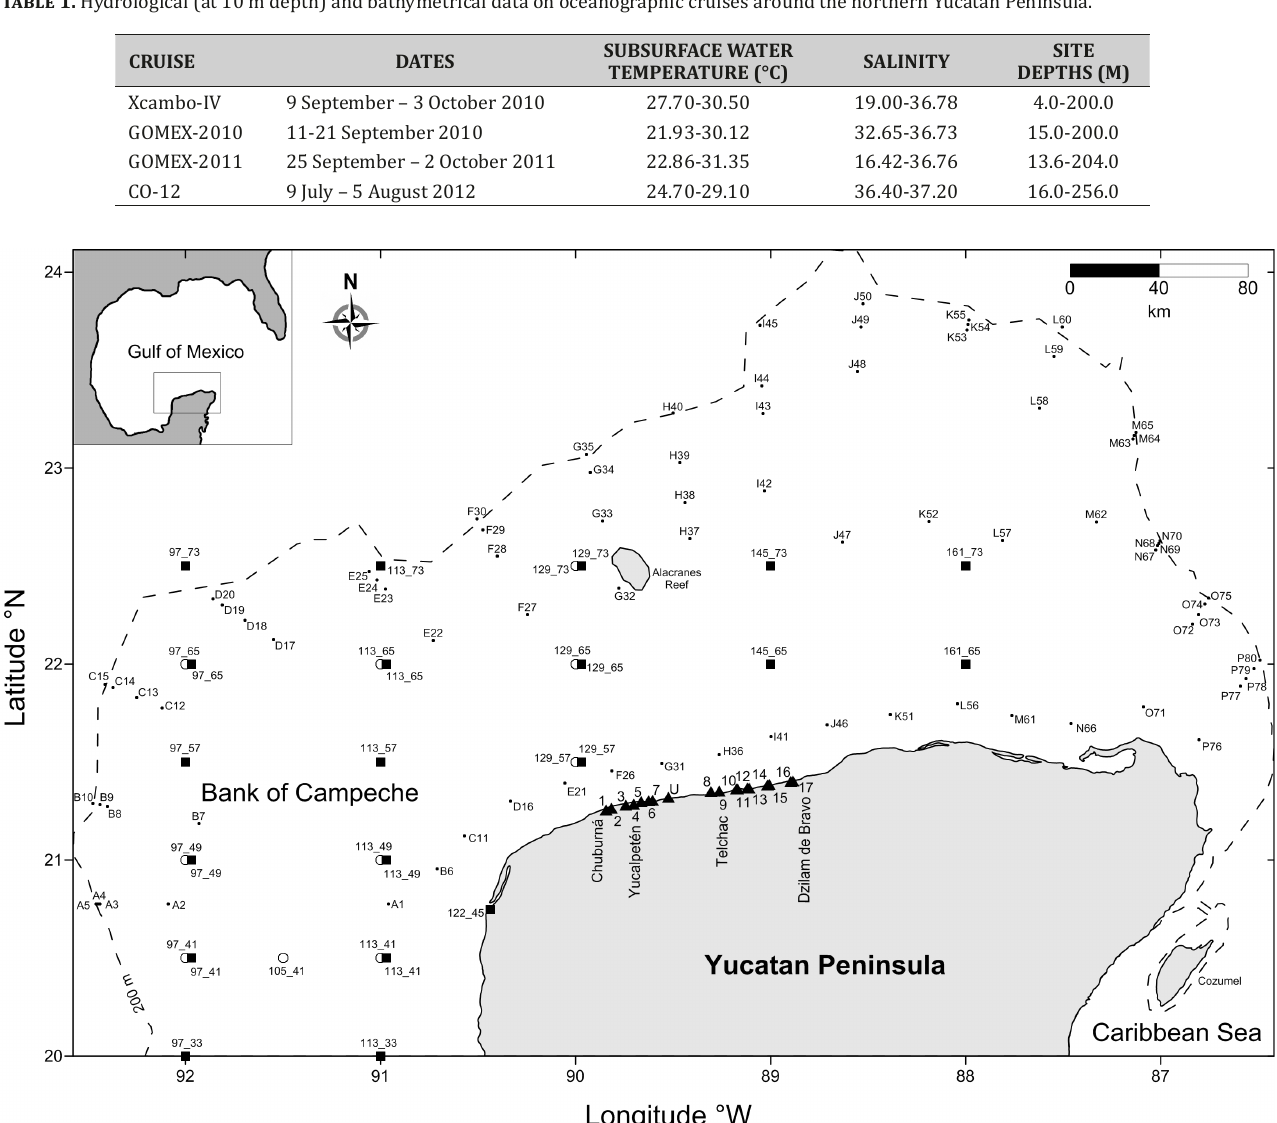
Figure 1. Sampling sites around the northern Yucatan Peninsula: filled triangles mean (oceanographic) stations of the coastal surveys (2001-2012), empty circles – Xcambo IV, filled small circles – GOMEX-2010 and GOMEX-2011; filled squares – CO-12.